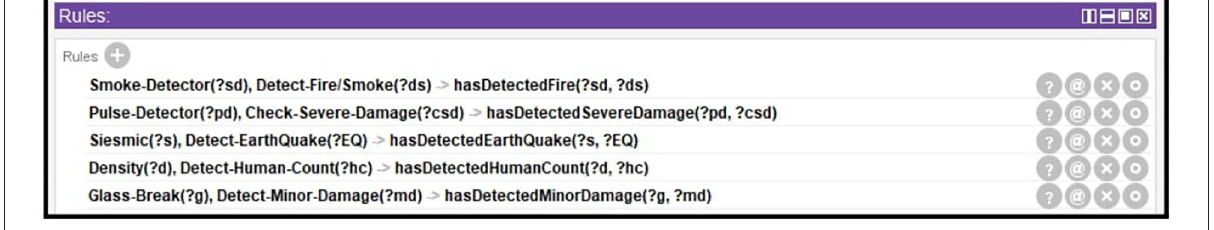
FIGURE4 Predefined set of rules for agents.